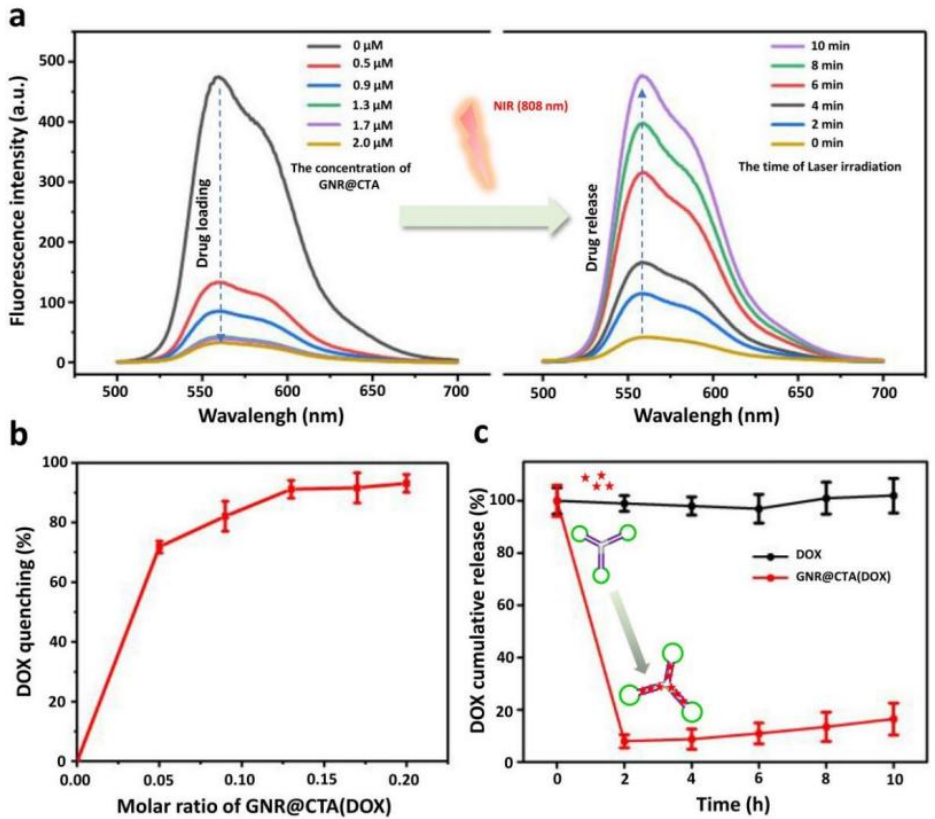
Figure 2. Loading and release of DOX by GNR@CTA. ( a ) Fluorescence analysis of GNP@CTA drug loading and NIR photothermal release. ( b ) Analysis of drug loading efficiency of GNR@CTA. ( c ) Analysis of GNR@CTA drug loading stability. Red “*” indicates free